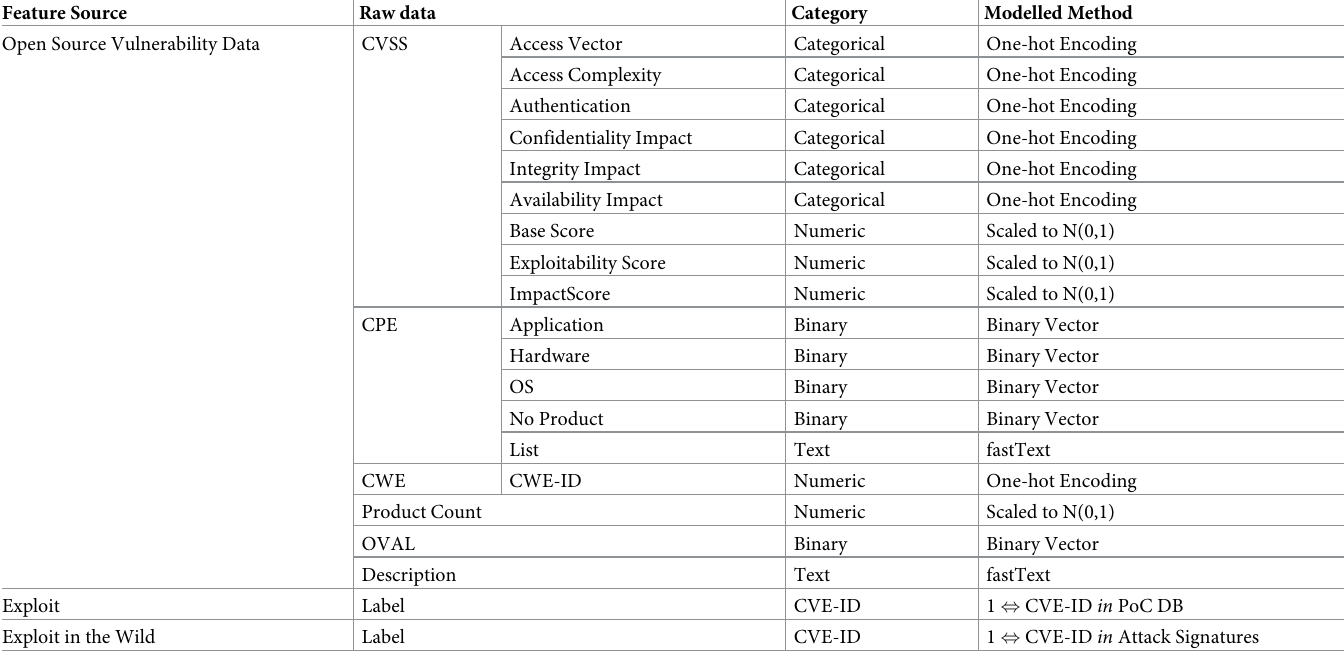
Table 2. Summary of data features, types and modelling